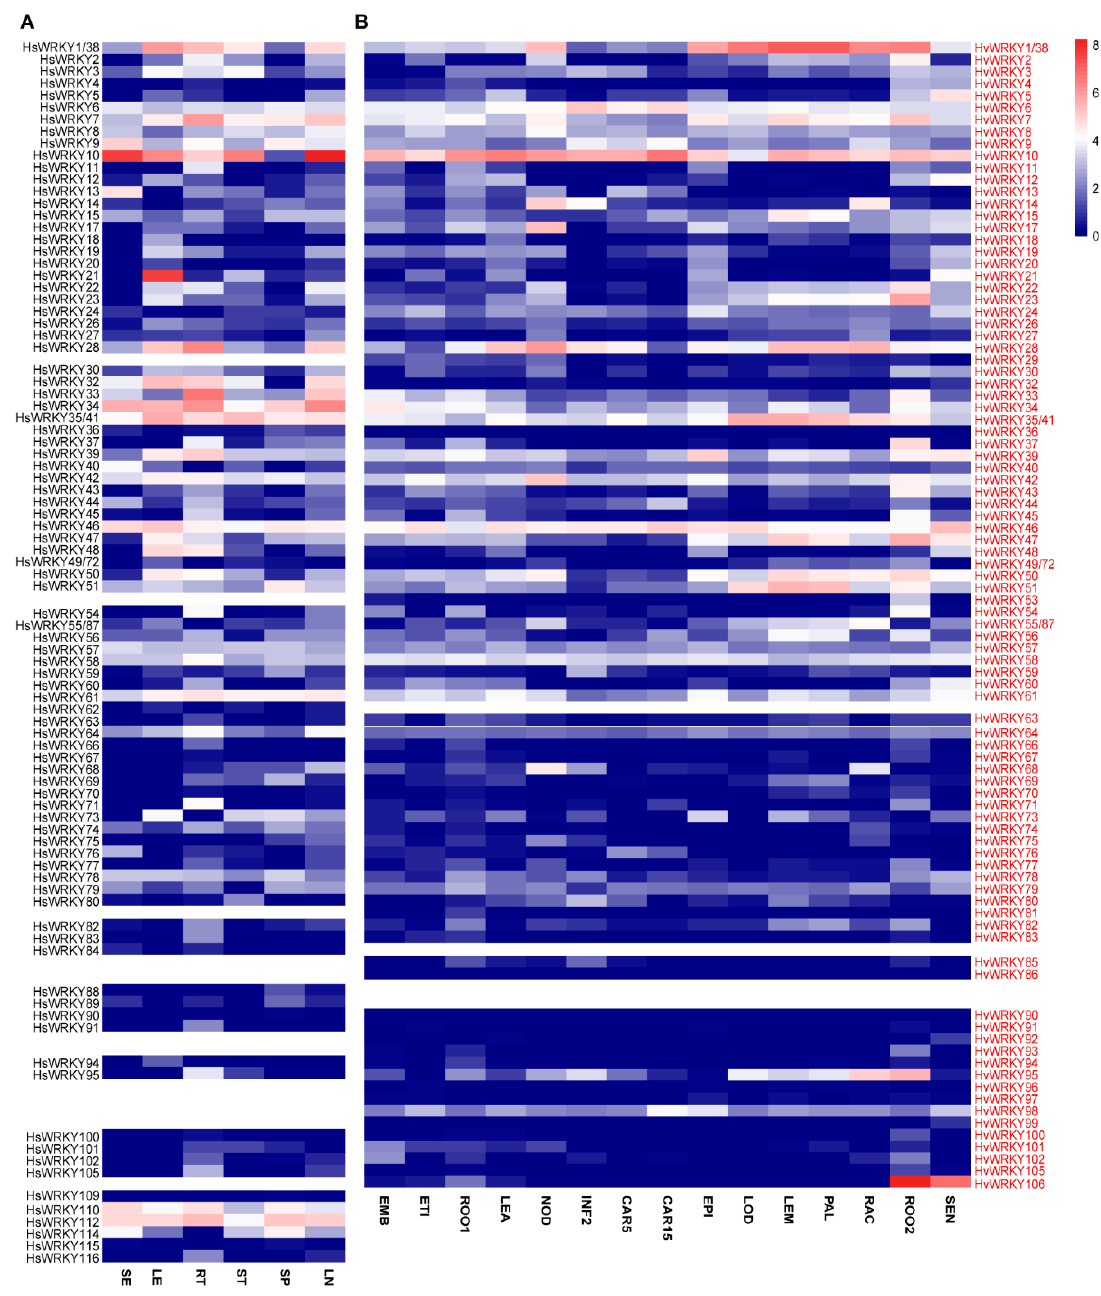
Figure 2. Transcriptional profiles of HsWRKY and HvWRKY genes. The expressional profile of WRKYs in different tissues from the wild ( A ) and cultivated ( B ) barley. SE, whole seedlings of 15 days after planting (dap); LE, leaves from seedlings at 25 dap; RT, roots collected at 30 dap; ST, first stems dissected at 42 dap; SP, spikelets obtained at anthesis; LN, developing kernels collected at 15 days post-anthesis. EMB, 4-day embryos; ETI, etiolated seedling at 10 dap, dark condition; ROO1, roots from seedlings (10 cm shoot stage); LEA, shoots from seedlings (10 cm shoot stage); NOD, developing tillers, 3rd internode at 42 dap; INF2, developing inflorescences (1–1.5 cm); CAR5, developing grain at 5 days post-pollination (dap); CAR15, developing grain (15 dap); EPI, epidermal strips (28 dap); LOD, inflorescences, lodicule (42 dap); LEM, inflorescences, lemma (42 dap); PAL, dissected inflorescences, palea (42 dap); RAC, inflorescences, rachis (35 dap); ROO2, roots (28 dap); SEN, senescing leaves (56 dap). Heatmap was generated based on logarithm values of FPKM and the colored scale for the expression levels is shown.